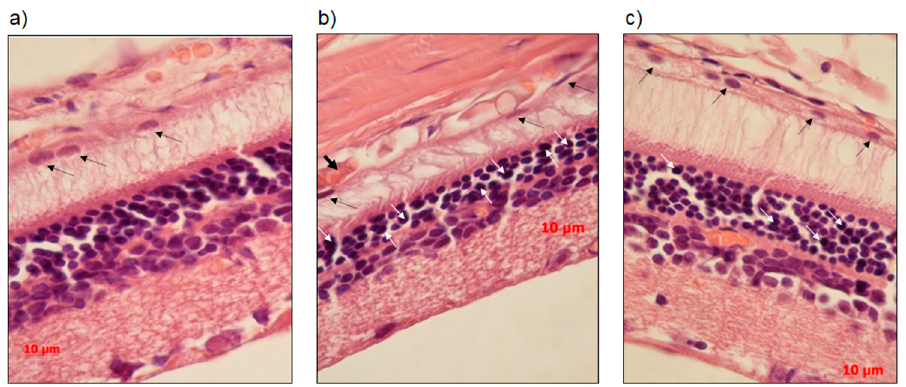
Figure 3. Representative images of hematoxylin and eosin staining from central retina of Wistar rats ( a ), OXYS rats ( b ) and OXYS treated with SkQ1 ( c ). The neuron with pyknosis (white arrow); the nucleus of the RPE cell (black dotted arrows); stasis and sludge of the blood cells in capillaries of the choroid (black arrow). The SkQ1 significantly reduced the percentage of neurons with pyknosis, ameliorated atrophic changes in RPE and choroid ( c ). The scale bar is 10 µm.